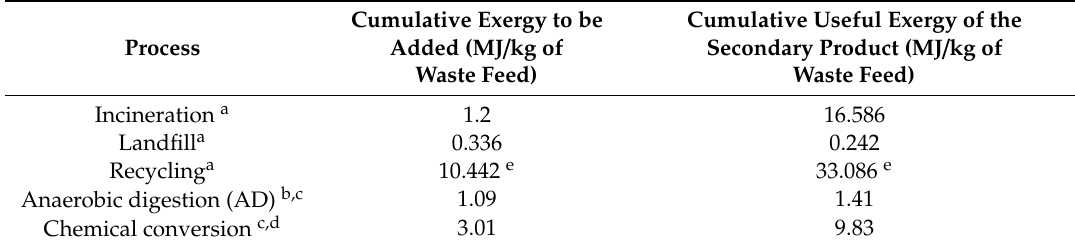
Table 6. Exergy calculation data for the MSW case study.